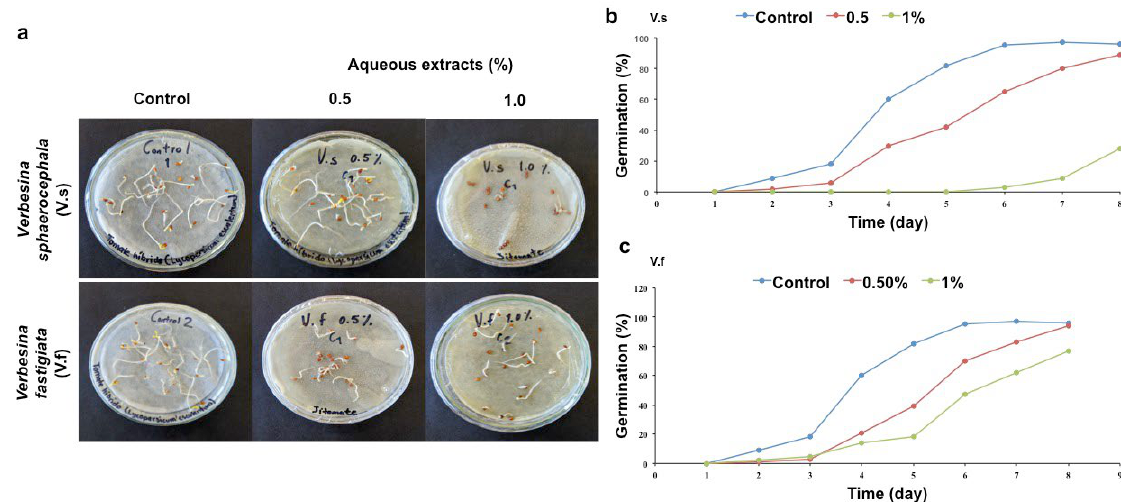
Figure 1. Germination of tomato ( Solanum lycopersicum ) seeds. ( a ) Application of the aqueous extracts of Verbesina sphaerocephala and Verbesina fastigiata at concentrations of 0.5 and 1.0%. ( b ) Germination percentages (GP) obtained with aqueous extracts of V. sphaerocephala ( n = 100, p = 0.05) and (c) V. fastigiata ( n = 100, p = 0.05).